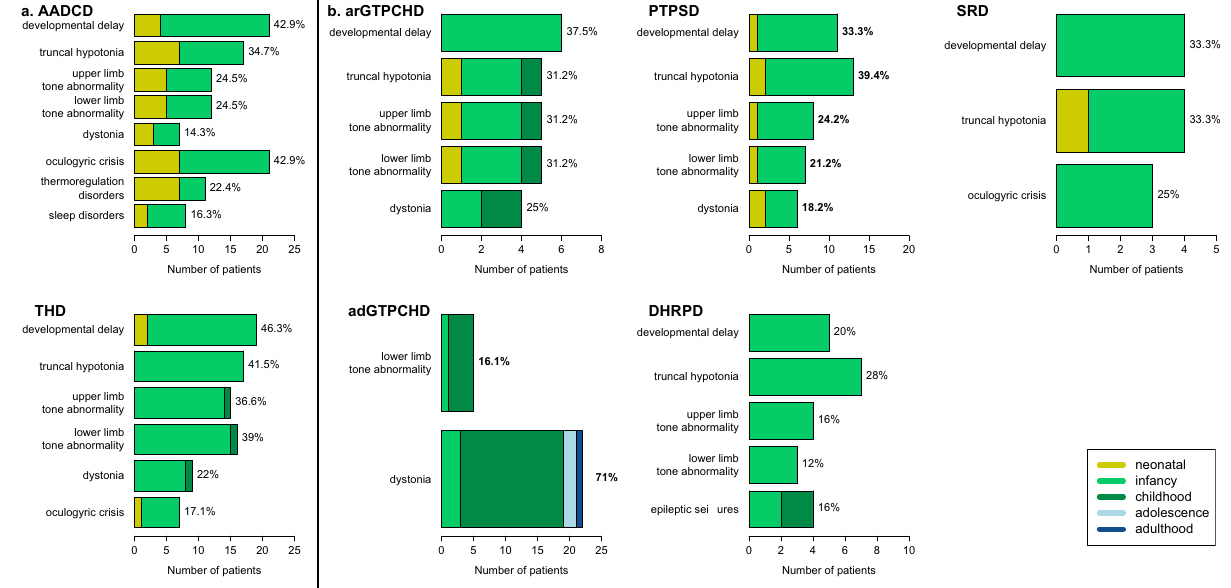
Fig. 3 Age dependency of initial symptoms. Age-dependent onset of initial symptoms in primary disorders of biogenic amine metabolism ( a ) and BH de fi ciencies ( b ). Initial symptoms reported in minimum 5 patients –– except in arGTPCHD, DHPRD and SRD in minimum 3 patients. The percentages correlate with available data about both occurrence of the symptom and age at onset of disease and not to the whole disease